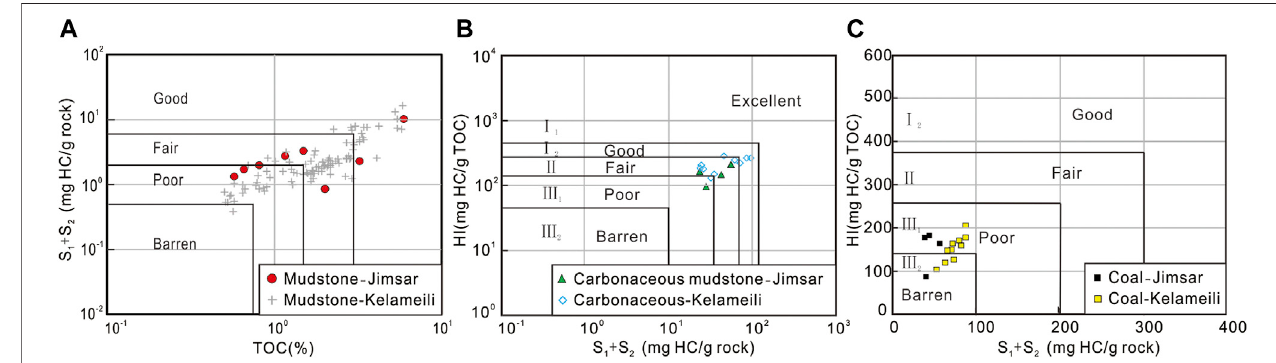
FIGURE7| TheabundanceoforganicmattersforC 1 s b (A) mudstones, (B) carbonaceous mudstones,and (C) coalsintheJimsar Sagand Kelameiligas fi eld(Plot after Chen et al., 1997).